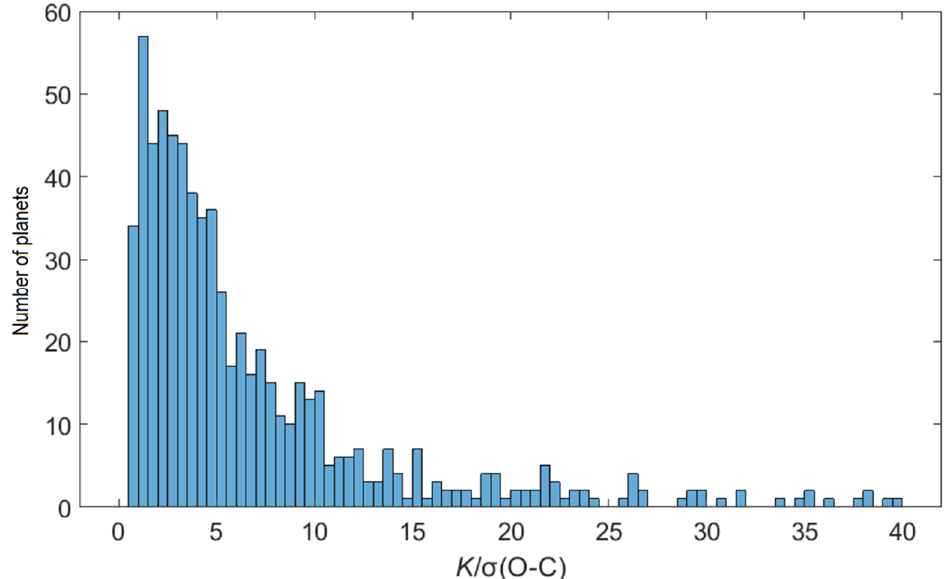
Figure 4. The distribution of RV planets over the ratio of the semi-amplitude K of the radial velocity oscillations of a host star to the average deviation σ(O − C) from the best Keplerian curve. For the majority of planets (95.1%), K /σ(O − C) > 1.0, i.e., the semi-amplitude K of